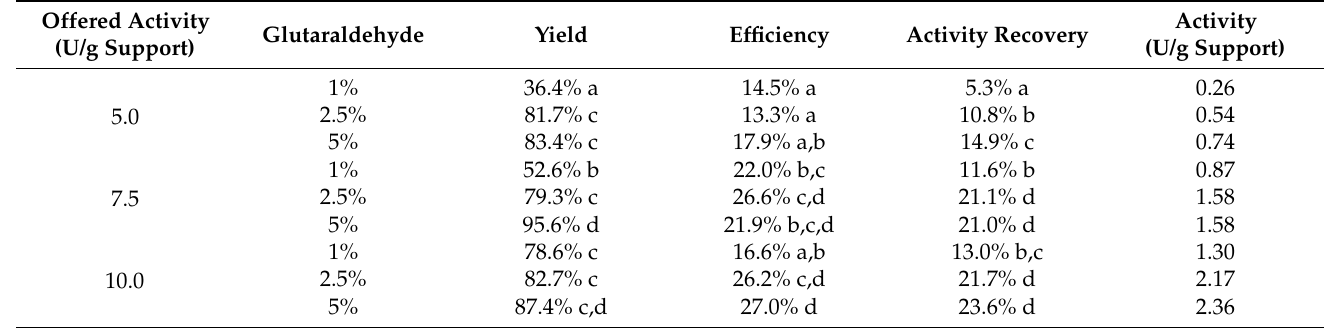
Table 1. ALDC immobilization on alginate/gelatin supports, evaluating the amount of enzyme offered and percentage of glutaraldehyde in the activation of